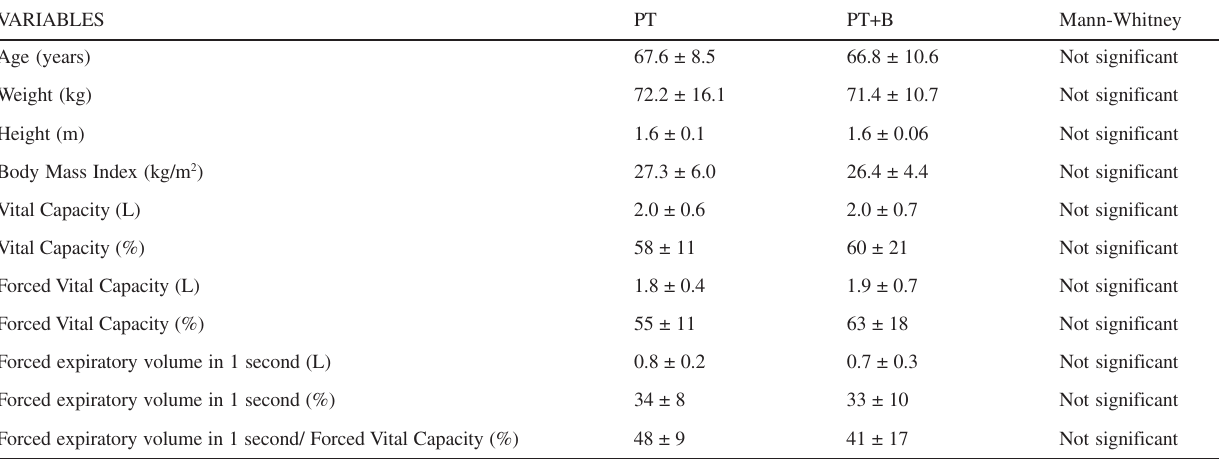
Table 1 - Anthropometric and pulmonary function tests of the study population in the physical training (PT) alone or associated with BiPAP (BT+B)